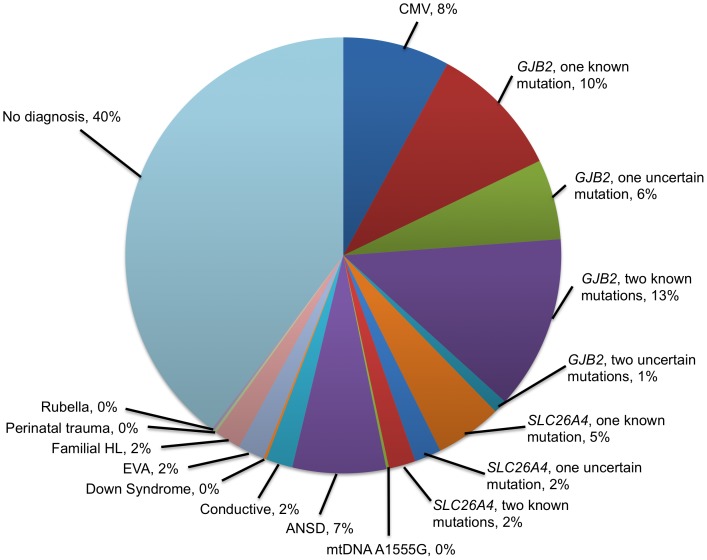
Results of the search for hearing loss etiology in 364 Australian children.